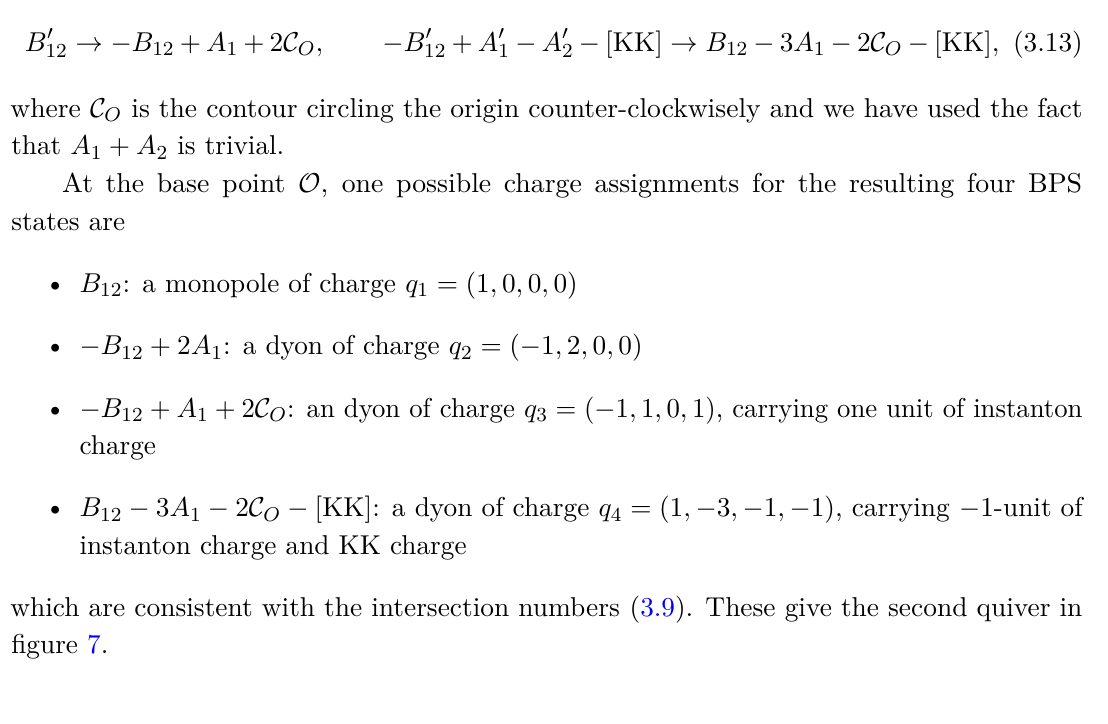
Figure 11 . The pullback of the contours B 0 + A 0 − B 0 − A 0 − [ KK ] at O 0 . Where the shift of KK-charge is due to the same 12 1 2